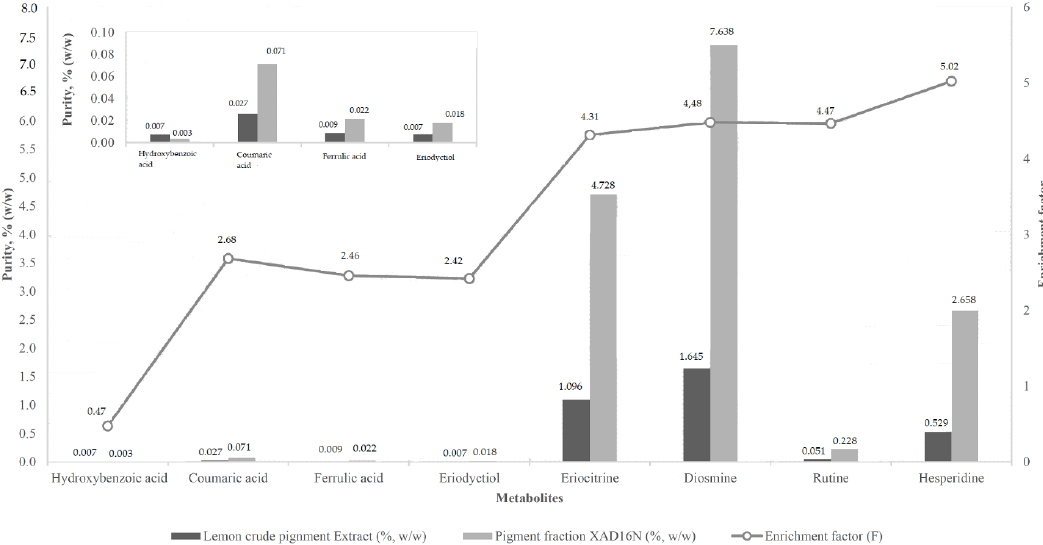
Figure 5. Comparison of LP extract purity before and after fractionation with Amberlite XAD16N resin. The enrichment factor (F) is given by the secondary axis.